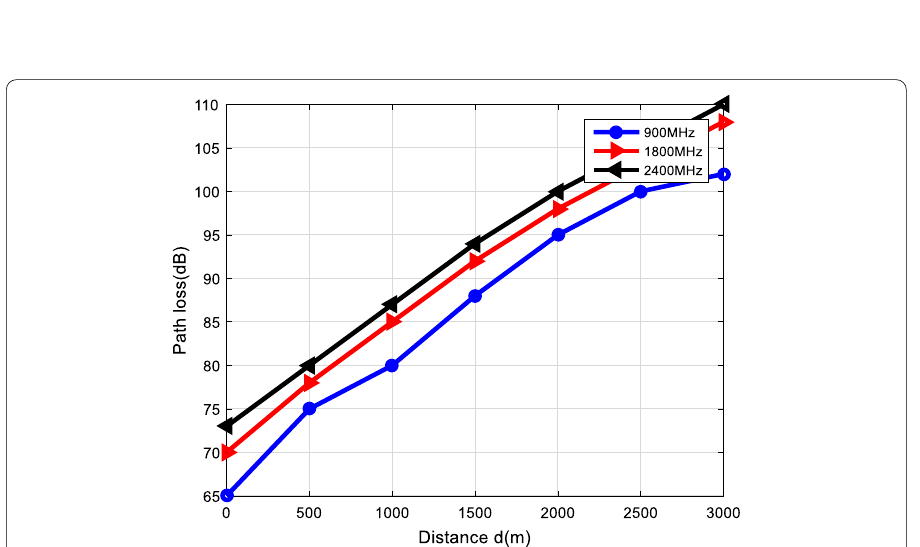
Fig. 3 Comparison of the propagation loss of the linear regression correction model of each base